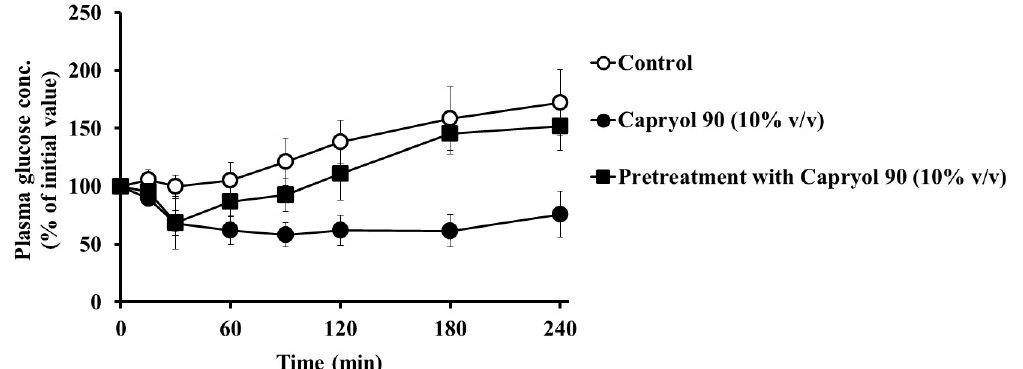
Figure 3. Effect of 10% ( v / v ) Capryol 90 pretreatment on the absorption of insulin from the small intestine using an in situ closed loop. Each value represents the mean ± S.E. ( n = 3).